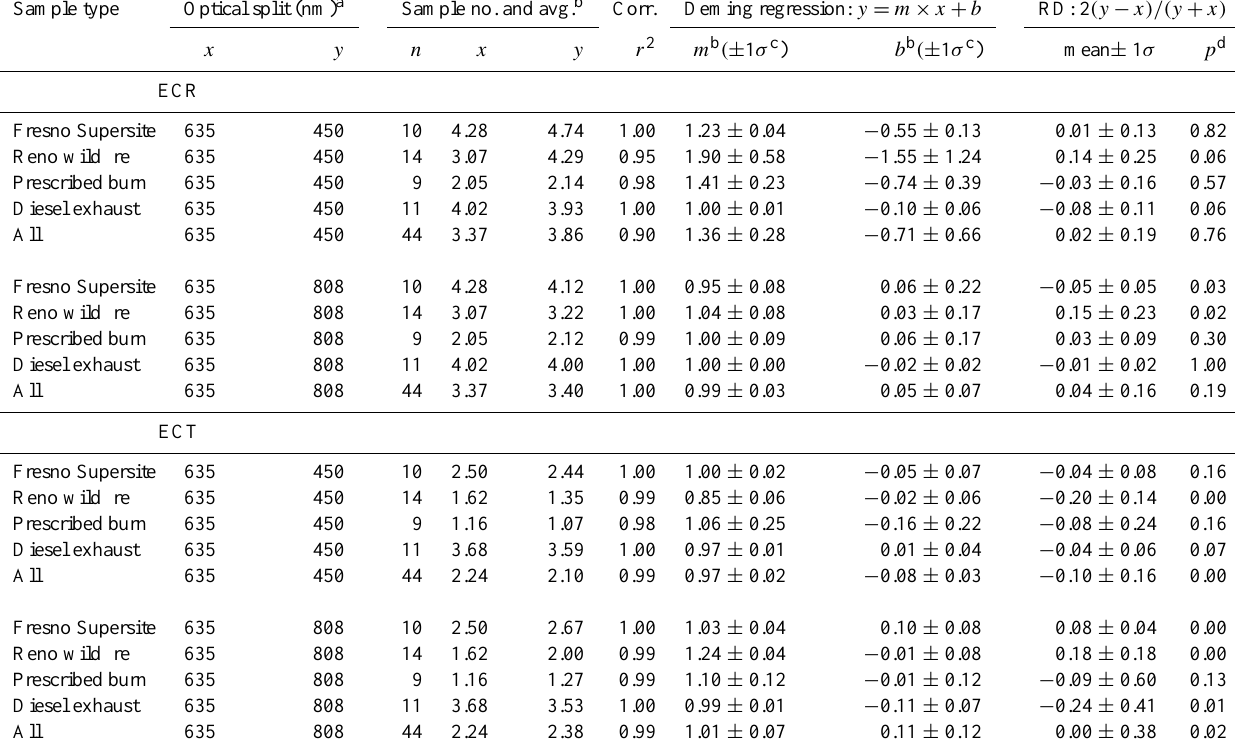
Table 2. Comparison of TSA-determined 635nm ECR and ECT with 880nm and 450nm following the IMPROVE_A protocol. Sample